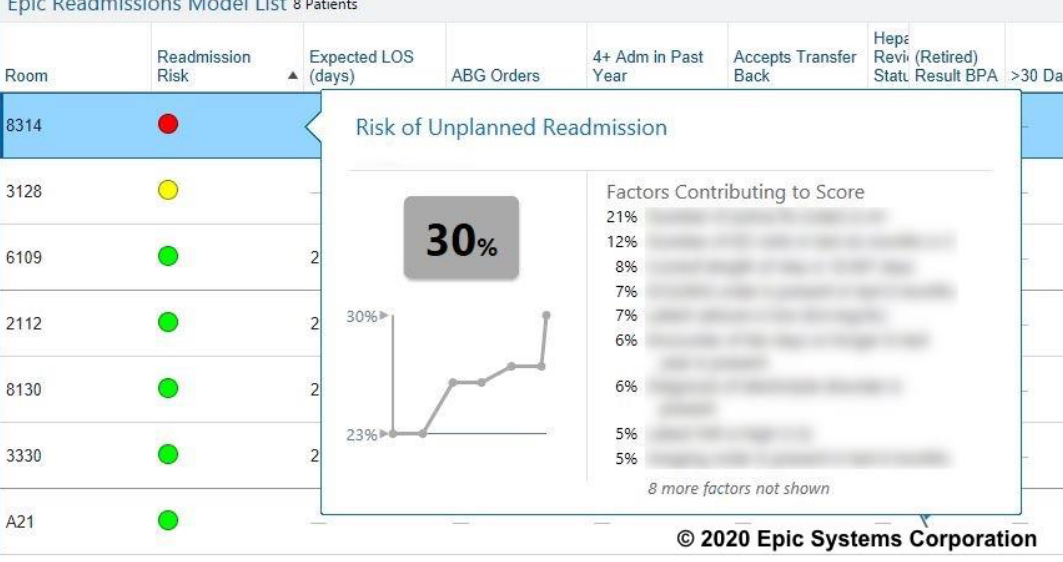
Figure 1. Epic Readmission Risk Model Appearance in Patient Lists. Risk variables blurred at request of Epic.